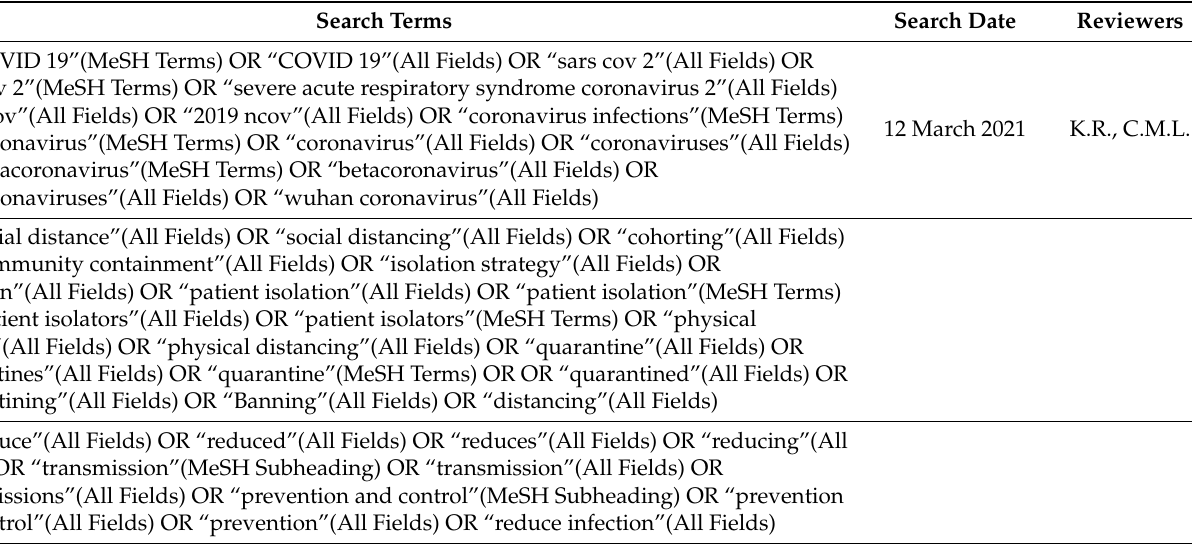
Table 1. Search strategy used for